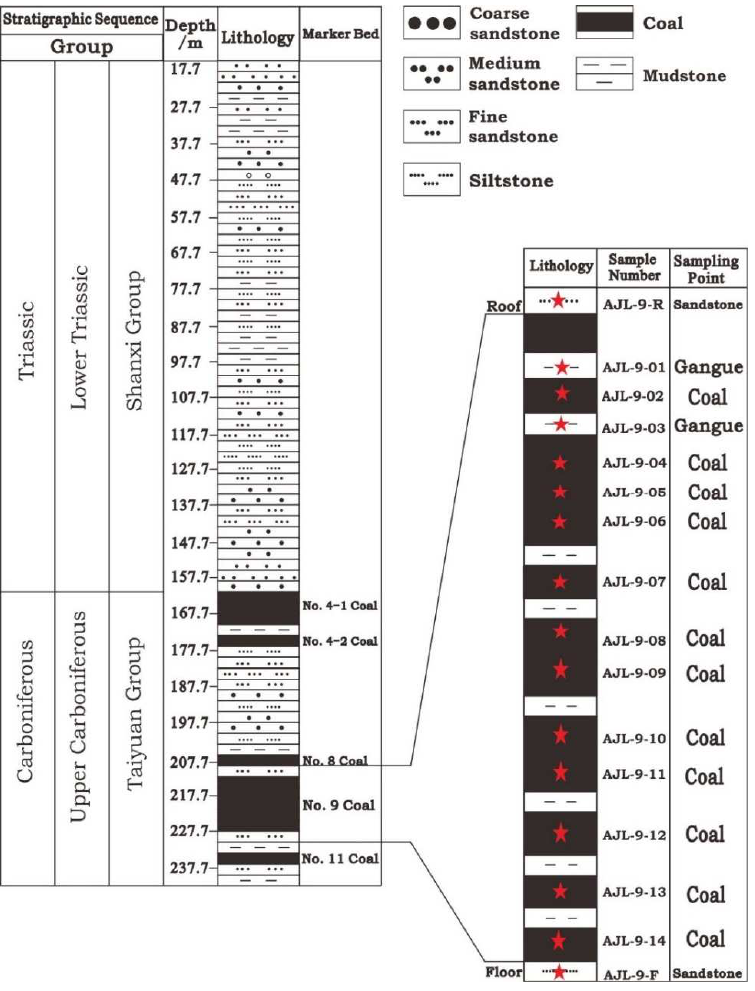
Figure 2. The stratigraphic sequence of the Anjialing coal mine and our sampling